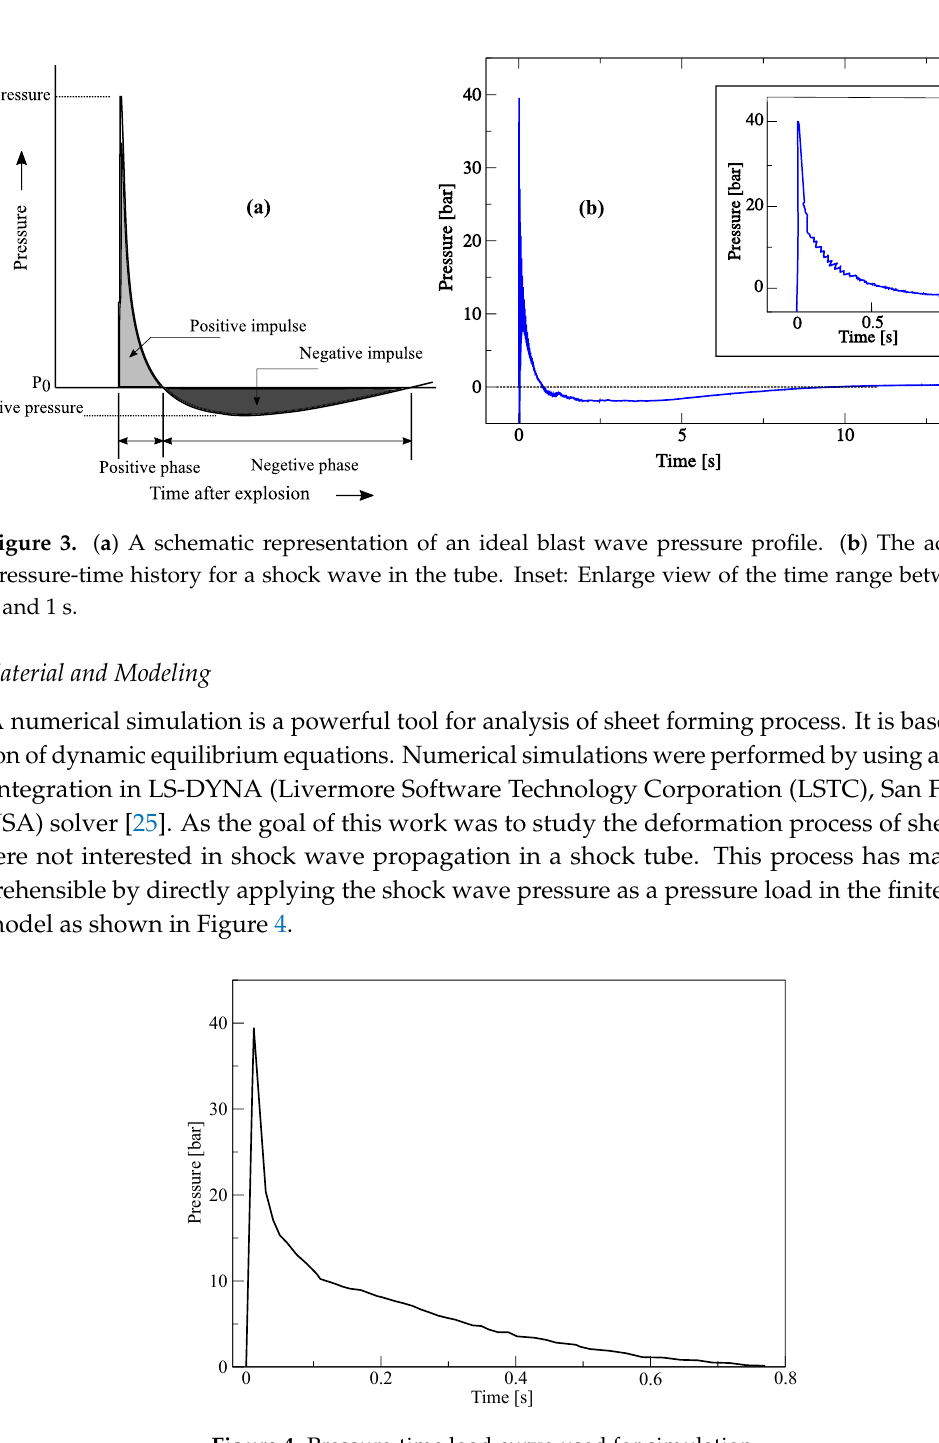
Figure 4. Pressure-time load curve used for